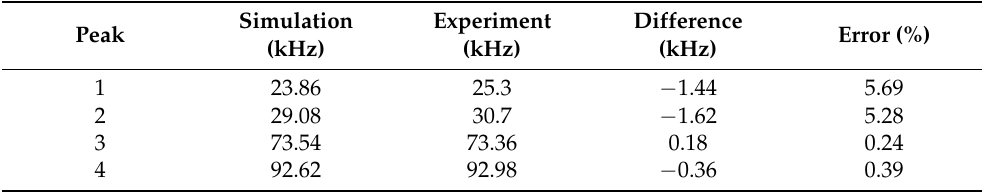
Table 3. The frequency of the impedance